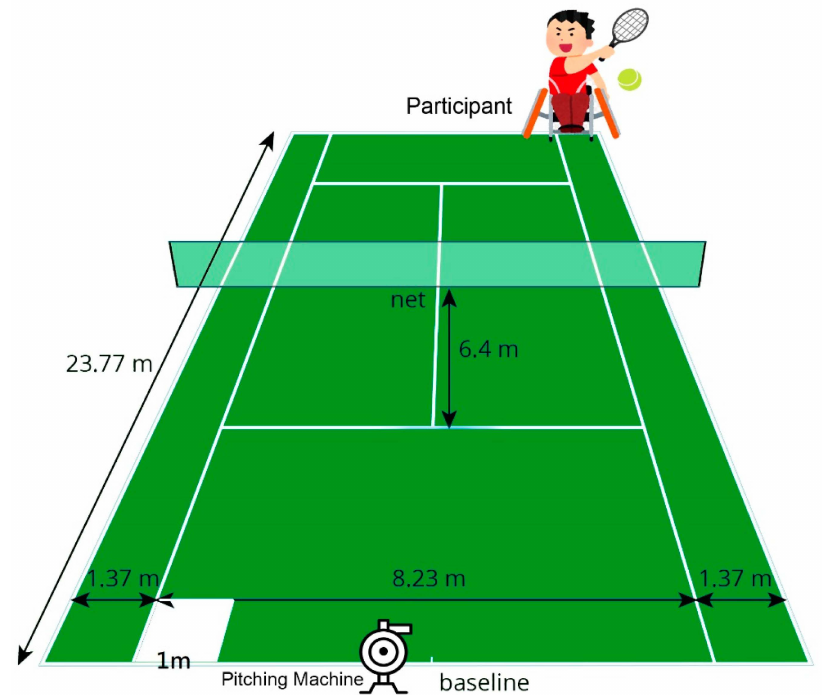
Figure 2. Tennis court and the target hitting